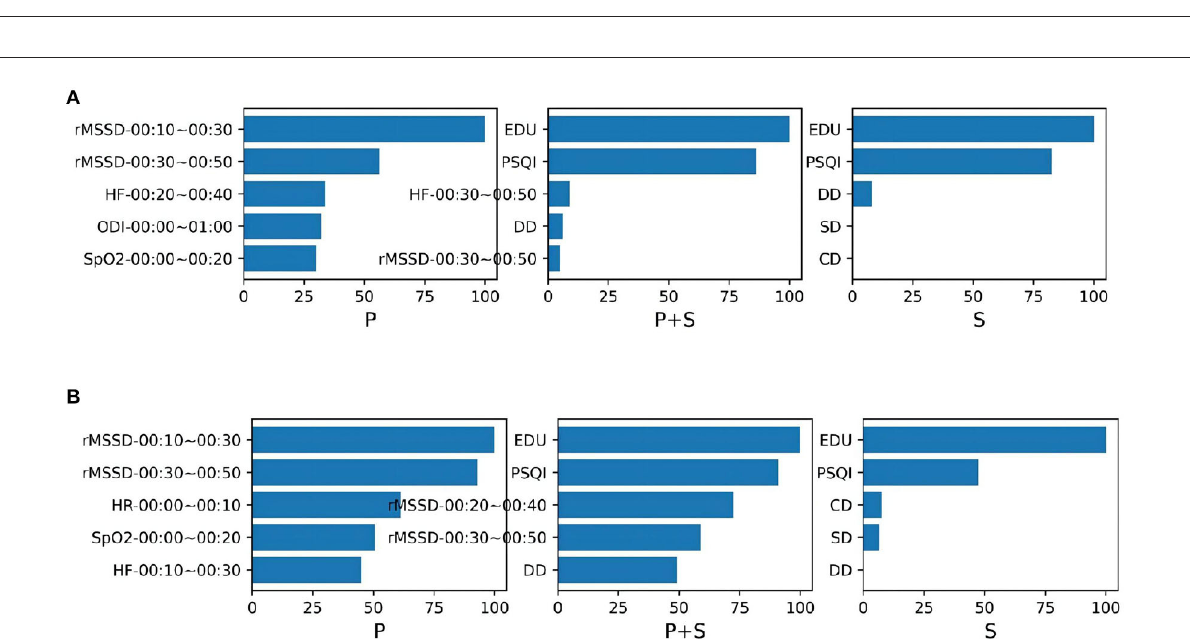
FIGURE5 The ROC curves of the MCI classification model including GBDT and XGBoost. Receiver operating characteristic curves. AUC (C statistics) is the corresponding values of the area under the curve for each model.